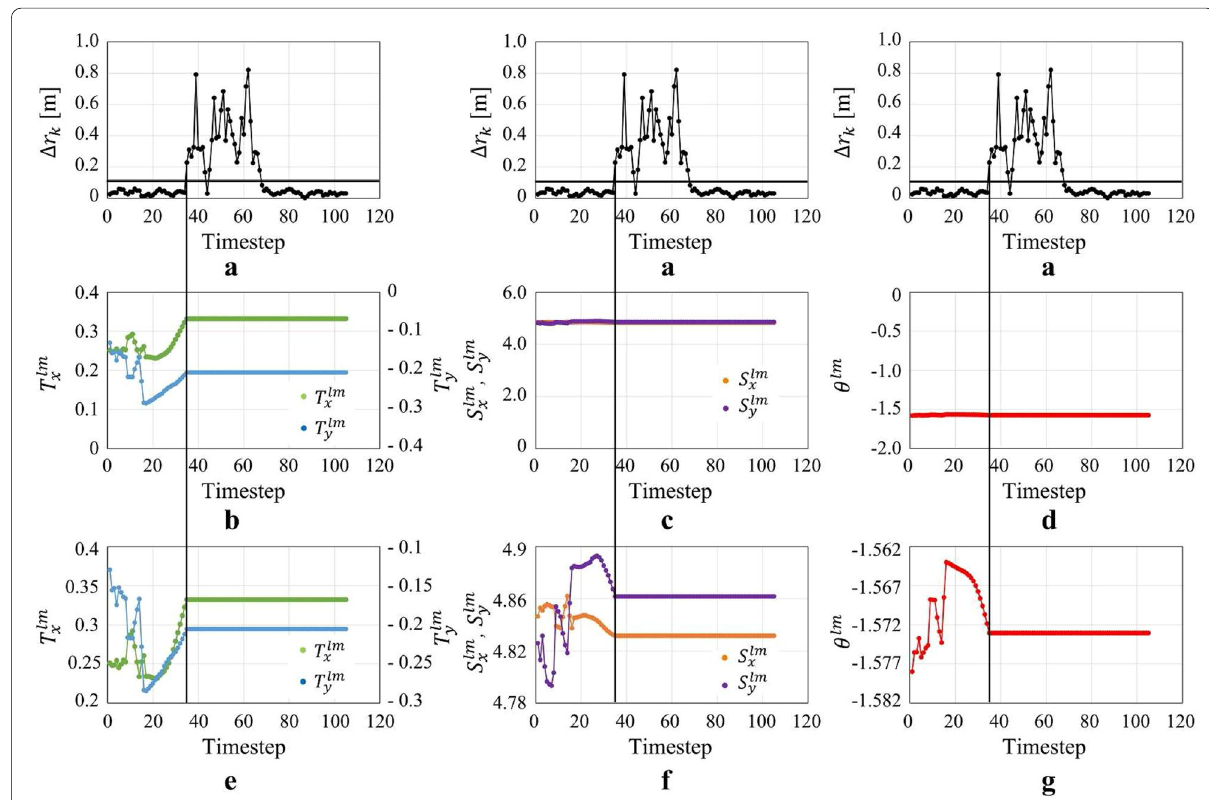
Fig. 10 Transition of the degeneracy detection index and transformation parameters in case of simulation dealing with degeneracy in the direction of translation. a degeneracy detection index, b , e Parameter transition of T lm x and T lm y , c , f Parameter transition of S lm x and S lm y , d , g Parameter transition of θ